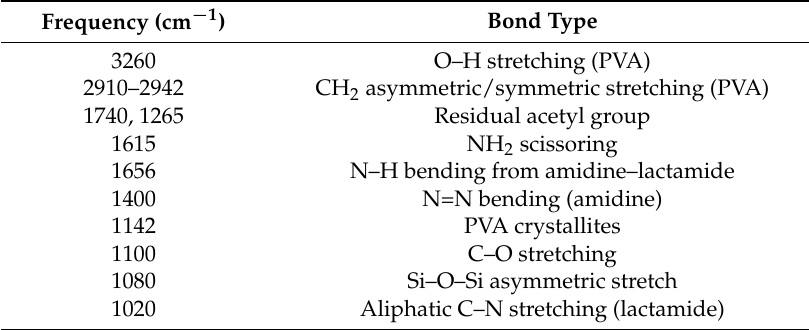
Table 1. Main infrared peaks of the nanocomposite membranes [36–42].